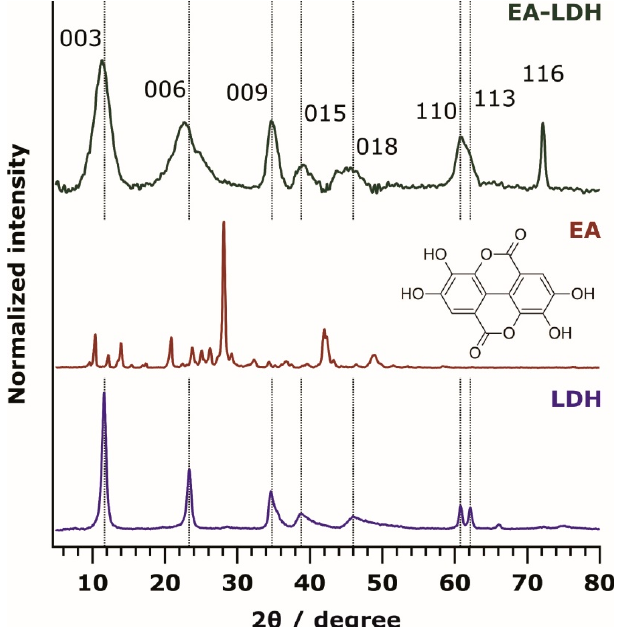
Figure 1. Powder XRD pattern of ellagic acid-layered double hydroxide (EA-LDH), EA, and LDH. The chemical structure of EA is shown in the inset. The Miller indices are indicated.